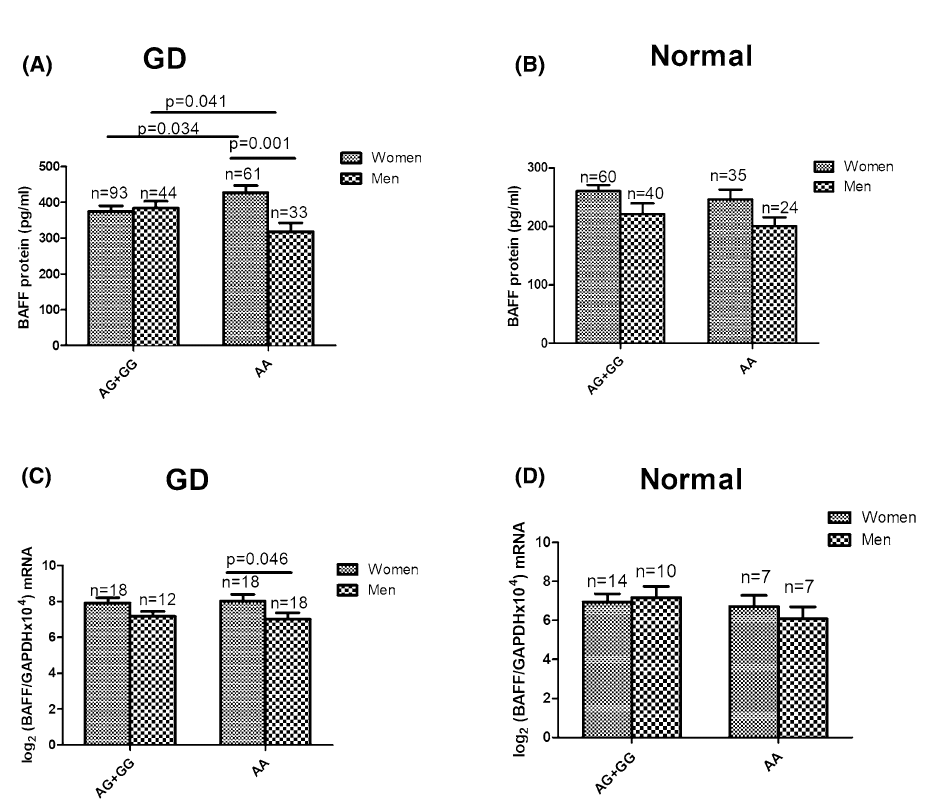
Figure 4. Comparisons of B-cell-activating factor (BAFF) protein ( A , B ) and BAFF mRNA levels ( C , D ) between women and men with different genotypes of rs2893321 in Graves’ disease (GD) and healthy